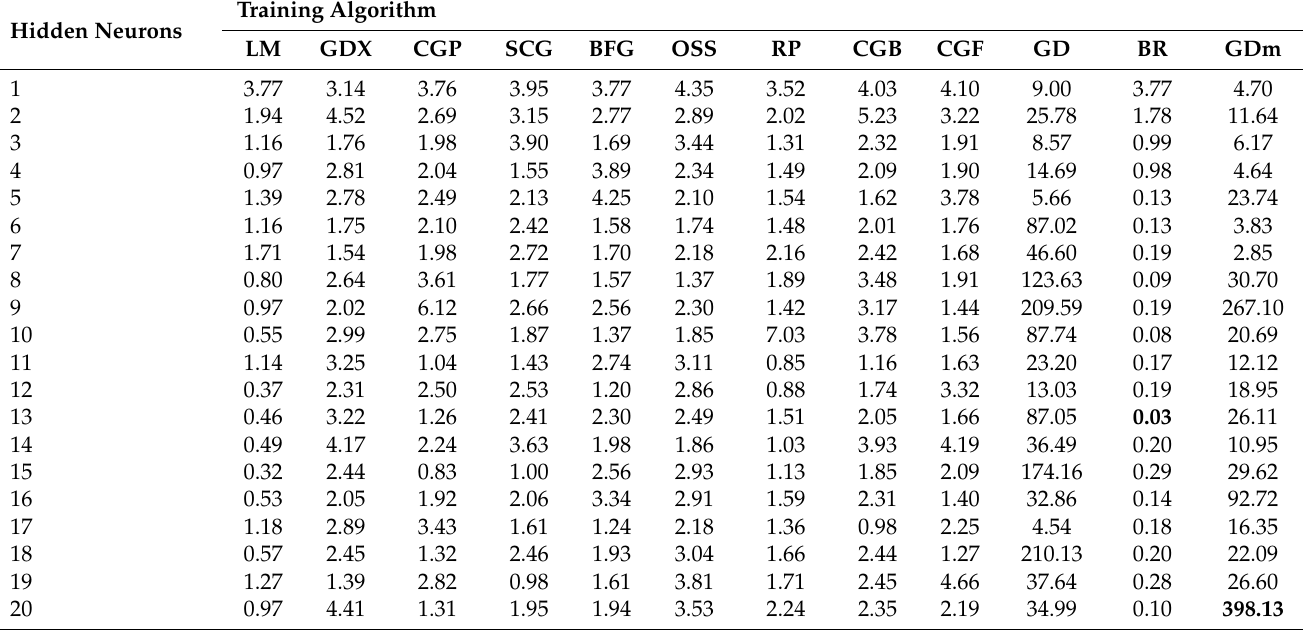
Table A14. MSE for percentage of CH4 in biogas for different training algorithms at different number of hidden